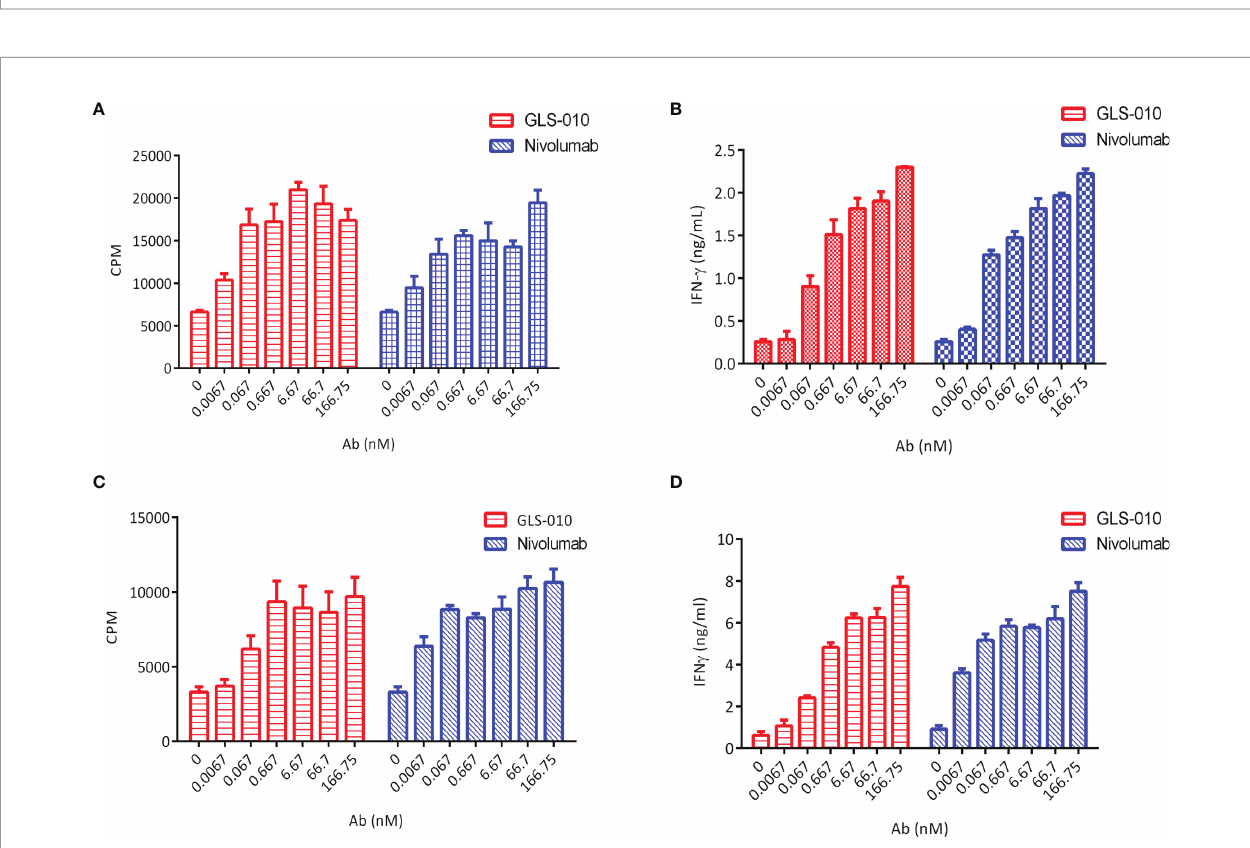
FIGURE 3 | Functional activity of GLS-010 in cell-based bioassays. (A) Induction of Human CD4 + T lymphocytes using allogeneic mixed lymphocyte reaction (MLR). (B) Induction of IFN- g activation of human CD4 + T cells using allogeneic MLR. (C) Induction of Human CD4 + T lymphocytes using autologous MLR. (D) Induction of IFN- g activation of human CD4 + T cells using autologous